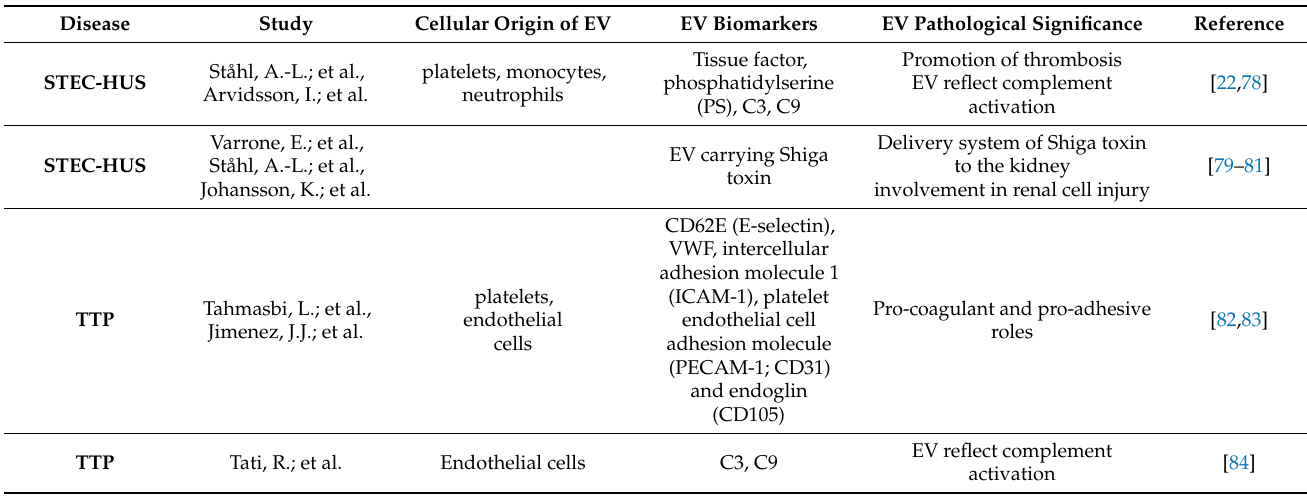
Table 3. Extracellular vesicles in thrombotic